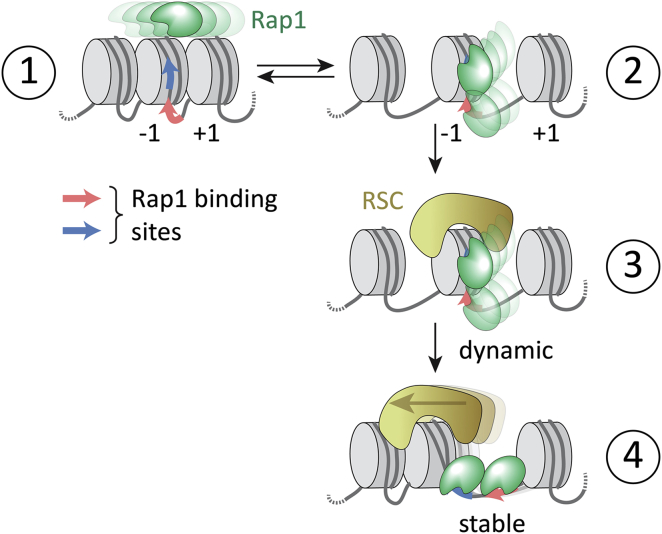
A Dynamic Model for Rap1-Mediated Promoter Chromatin RemodelingRap1 searches chromatin (step 1) and its dynamic binding (2–25 s) to a promoter site results in local chromatin opening (step 2), where Rap1 remains dynamically bound. RSC-mediated nucleosome sliding opens the NDR and exposes the DNA containing Rap1 binding sites (step 3). The fully exposed binding sites allow stable Rap1 binding (step 4) with long residence times (free DNA τres > 450 s) and prevent further nucleosome encroachment.